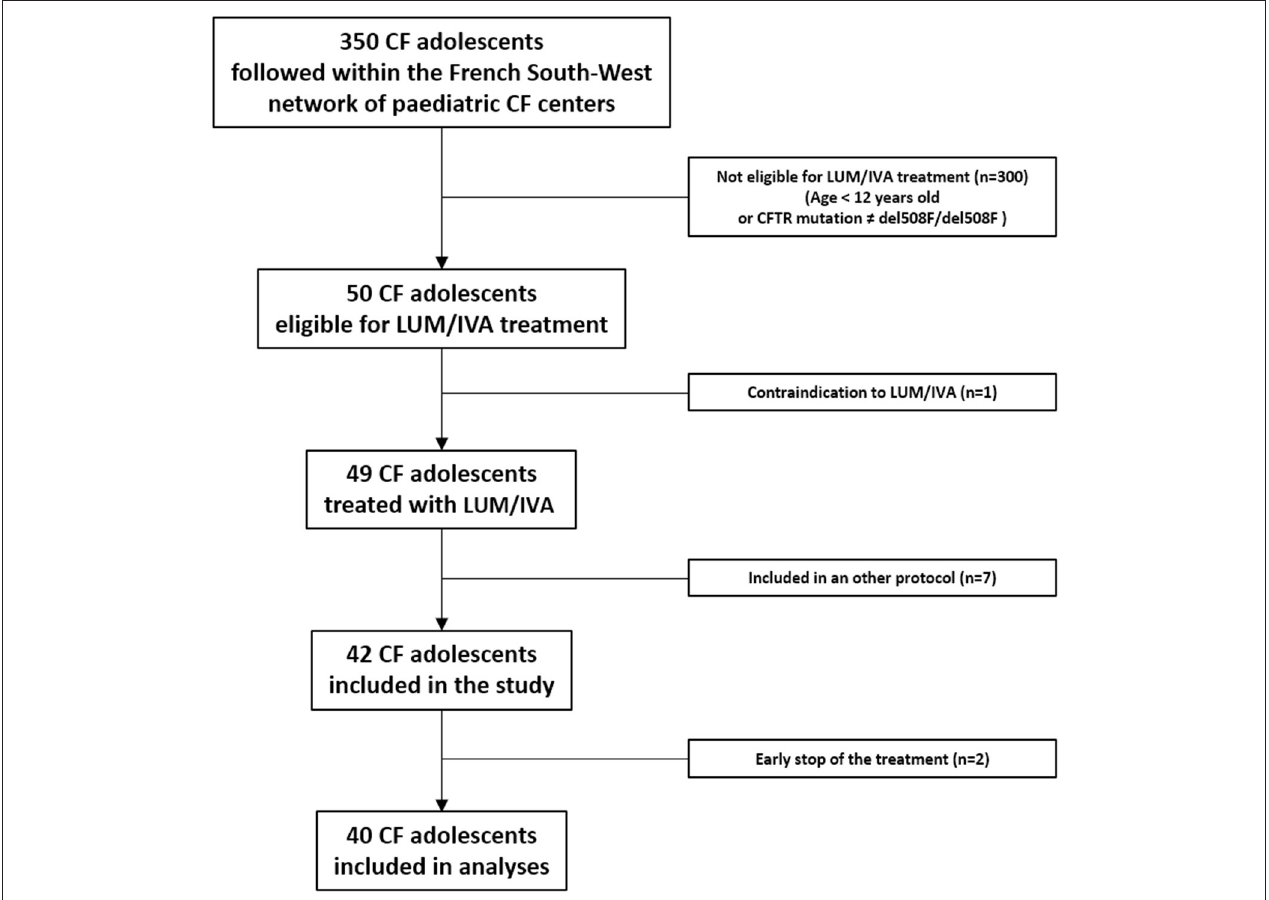
FIGURE 2 | Flow chart. CF, cystic fibrosis; LUM/IVA, lumacaftor/ivacaftor association; del508F/del508F, homozygous deletion of the codon for phenylalanine at position 508 in the cystic fibrosis transmembrane regulator (CFTR) gene.